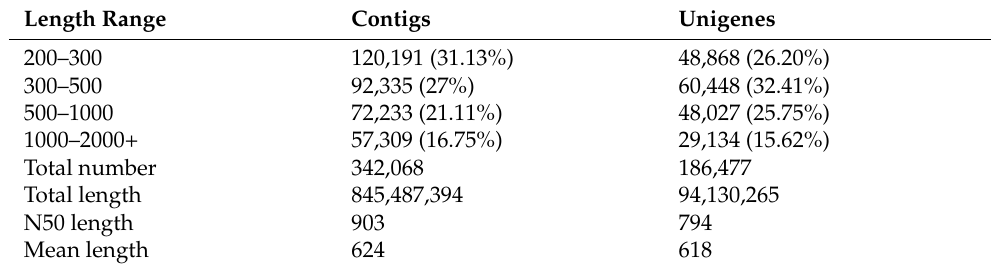
Table 1. Length-wise distribution of contigs and unigenes in the transcriptome of Hydrangea